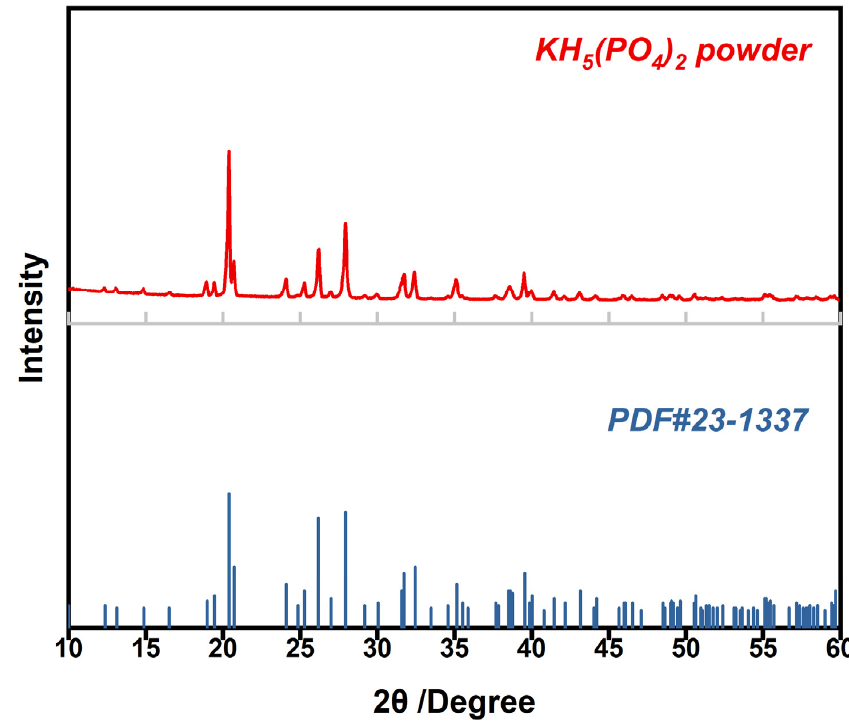
Figure 1. XRD pattern of KH 5 (PO 4 ) 2 powder (red color); the peak position of standard PDF card of KH 5 (PO 4 ) 2 (PDF# 23-1337, blue color).